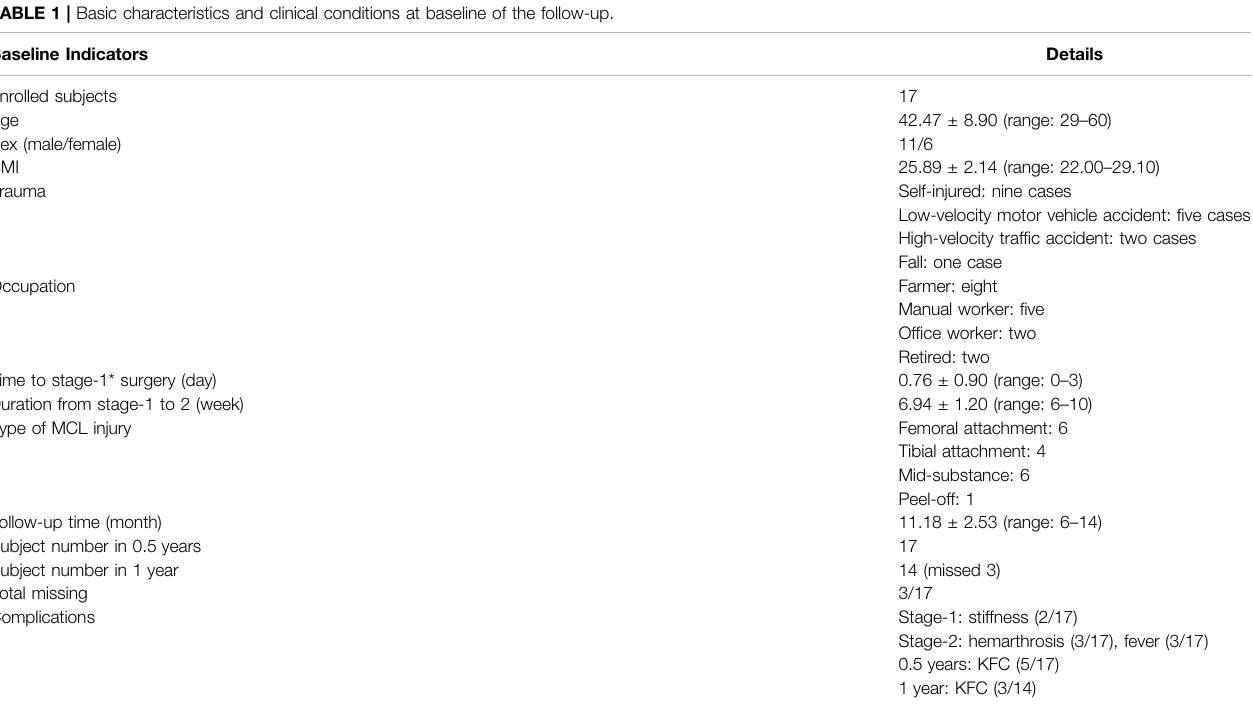
TABLE 1 | Basic characteristics and clinical conditions at baseline of the